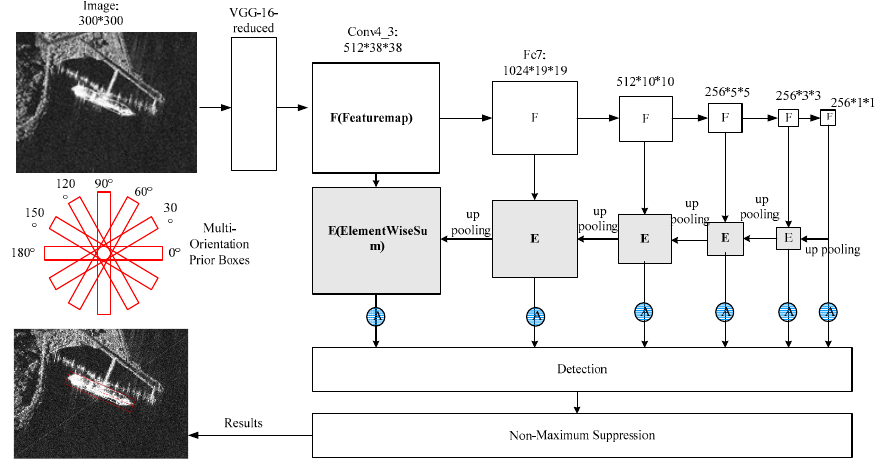
Figure 2. The overall architecture of the proposed method, inherited from the original SSD. It finds ships using rotatable anchor boxes on SAR images and outputs the category, location and orientation of the ships. F represents the feature map, E represents the element-wise summation, and A represents the attention module.